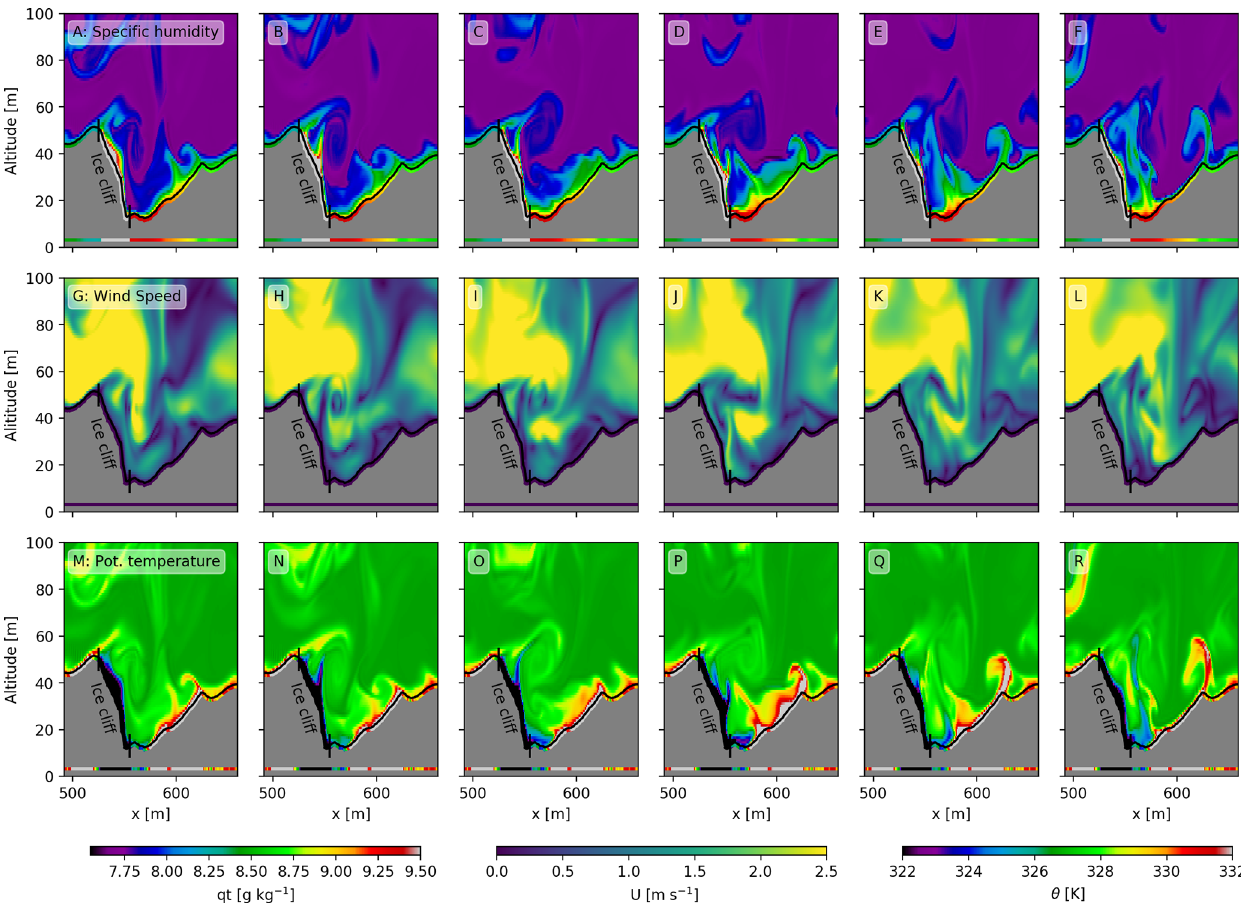
Figure 10. The specific humidity (a–f) , wind speed (g–l) and temperature (m–r) for a close-up around an ice cliff (660 < x > 500m) at time = 6570–6630s with a 10s time interval. The black line indicates the topography. The surface boundary conditions are plotted directly below the surface and, for clarity, also at y =